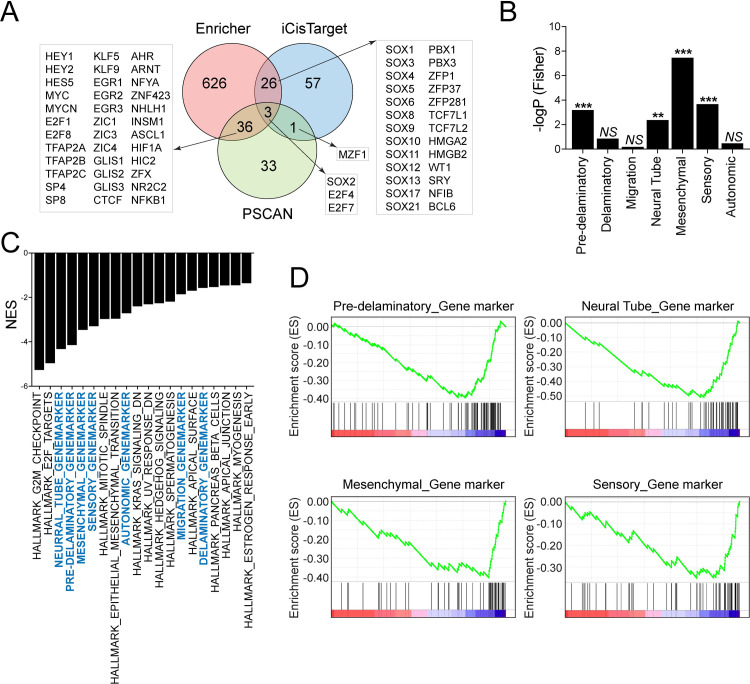
Altered transcriptional network due to BAF155/170 deletion in NCCs.(A) Venn diagram on transcription factors which show significant enrichments in the BAF155/170-deficient (Wnt1Cre/+;BAF155fl/fl;BAF170fl/fl) NCCs compared to the controls. RNAseq data were analyzed via Enrichr, Pscan, and iCisTarget. (B) Fisher’s test showing enrichment of differentially expressed neural crest genes in scRNAseq clusters identified by Soldato et al., 2019. (C) GSEA analysis showed that custom pathways (with cluster genes identified by Soldato et al., 2019, highlighted with blue color) are retrieved as top GSEA hits (top 20 pathways are presented). Pathways that are significant in the Fisher test occupy a higher rank in the GSEA output. (D) GSEA was performed to analyze the custom pathways affected by BAF155/170 deletion in NCCs.